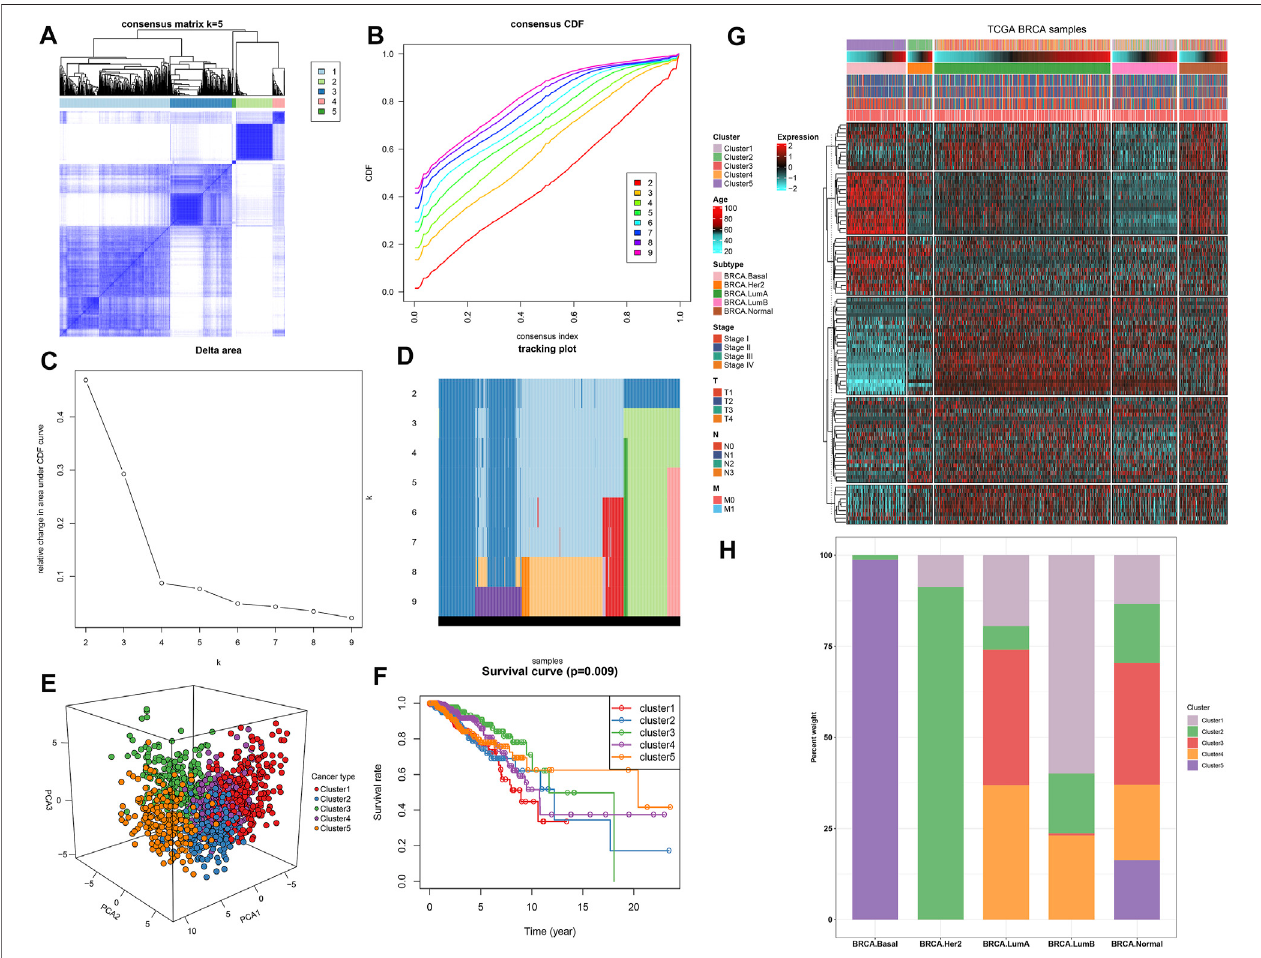
FIGURE 8 | Establishment of fi ve TSG-based subtypes with different clinical outcomes across breast cancer in TCGA dataset. (A) Consensus matrix when k = 5. (B) Consensus CDF diagram for the consensus distribution when k = 2 – 9. (C) Delta area under CDF curves when k = 2 – 9. (D) Item tracking plot for the consensus clusteringofitemscorrespondingtoeachk. (E) Principalcomponentanalysis(PCA)plotsforthedifferenceamong fi veclustersbasedonthemRNAexpressionofthetop 100 TSGs with the most variance. (F) Kaplan – Meier curves and log-rank test of fi ve clusters. (G) Heat map visualizing the clinical phenotypes in fi ve clusters. (H) Comparison of fi ve TSG-based subtypes and known breast cancer